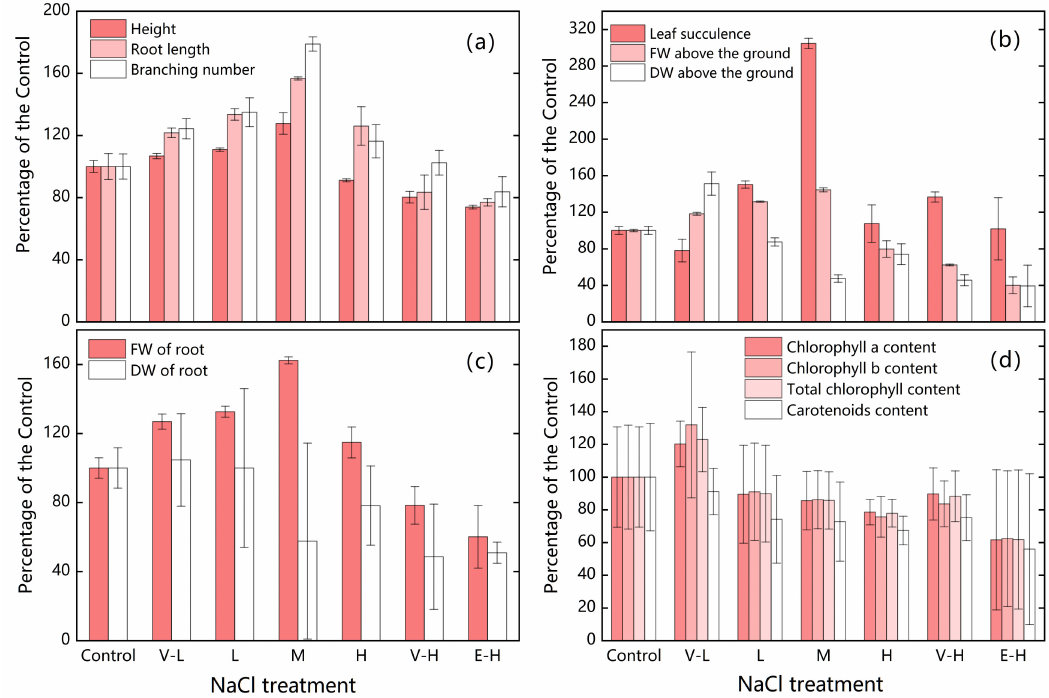
Figure 3. E ff ects of di ff erent salt concentration stress on various physiological indexes of Suaeda salsa . The control group was set to 100%, and the remaining six groups were changed relative to the control group. The values were means ± standard errors (n = 3). The real values are presented in Table 3. (( a ) plant height, root length, number of branches; ( b ) leaf succulence, FW above the ground, DW above the ground; ( c ) FW of root, DW of root; ( d ) chlorophyll a, chlorophyll b, total chlorophyll contents and carotenoid content of Suaeda salsa